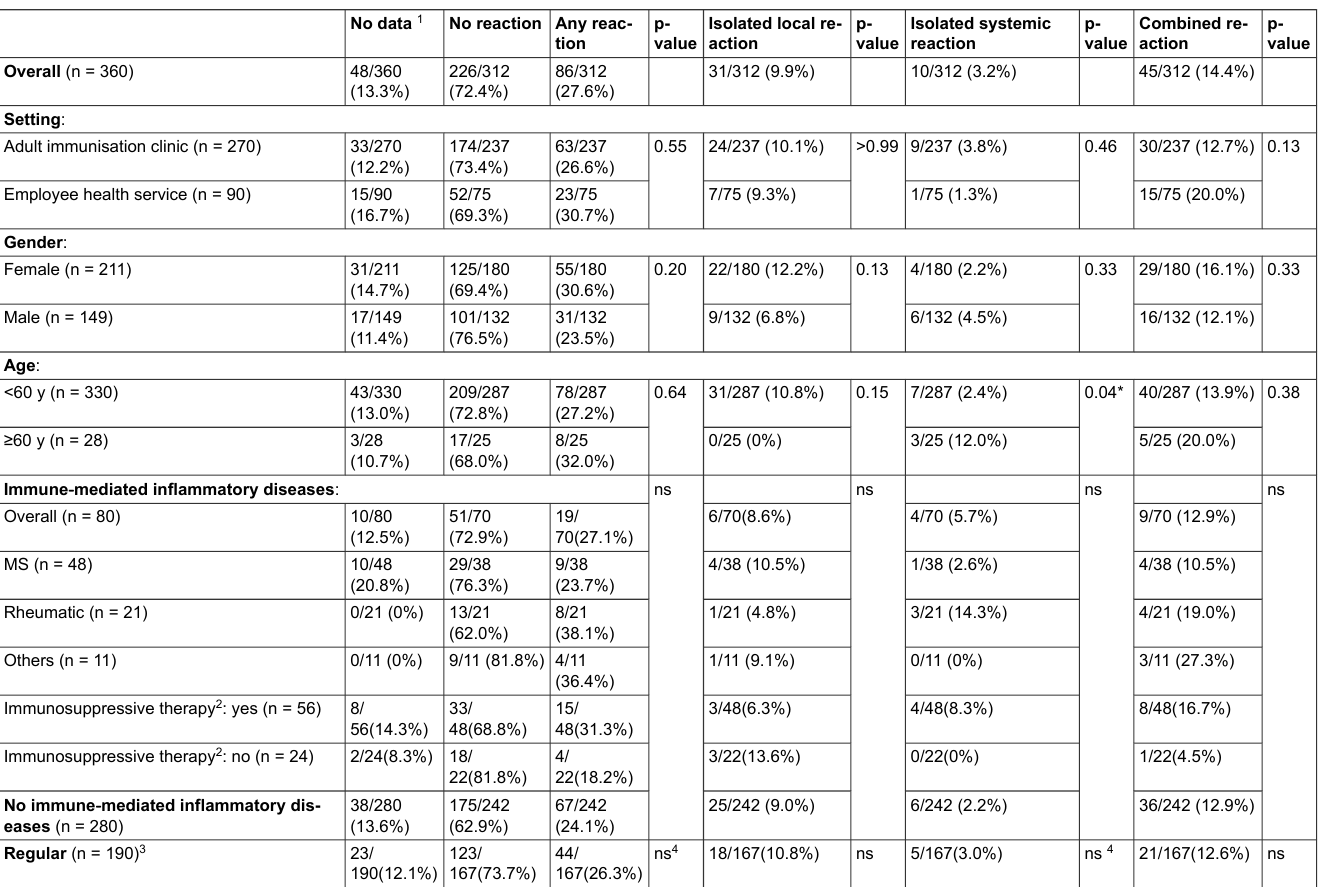
Table S1: Comparison of reported AEFI in different